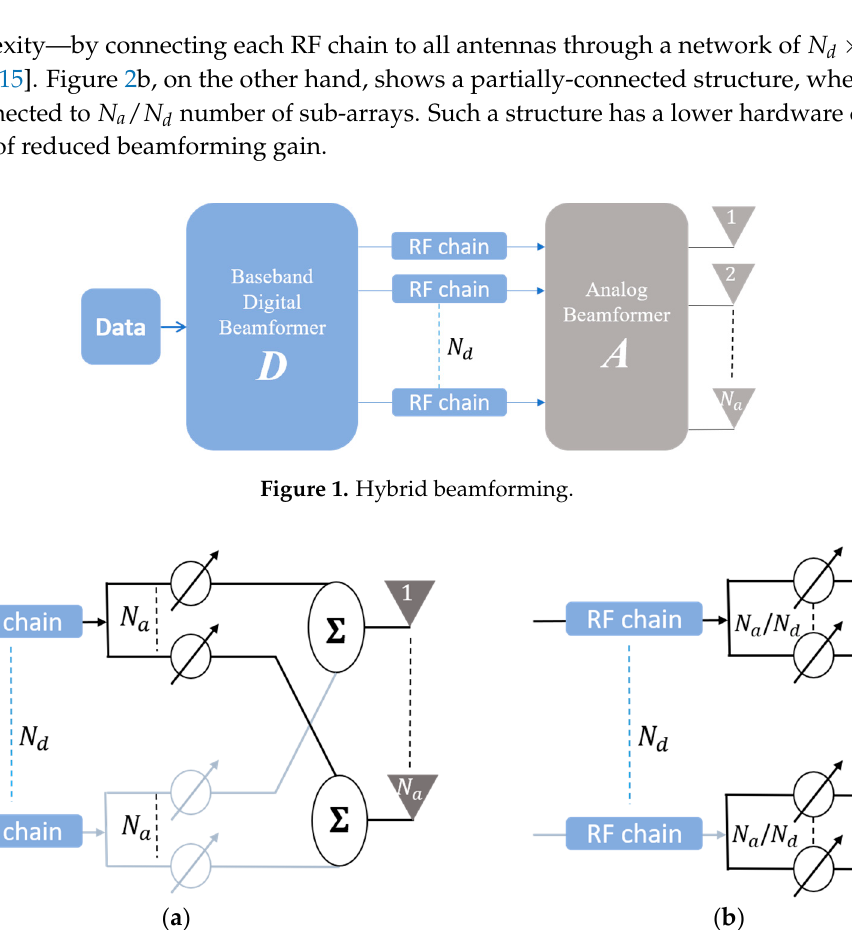
Figure 2. The architecture of analog beamformers: ( a ) Fully-connected structure; ( b ) partially- connected structure.